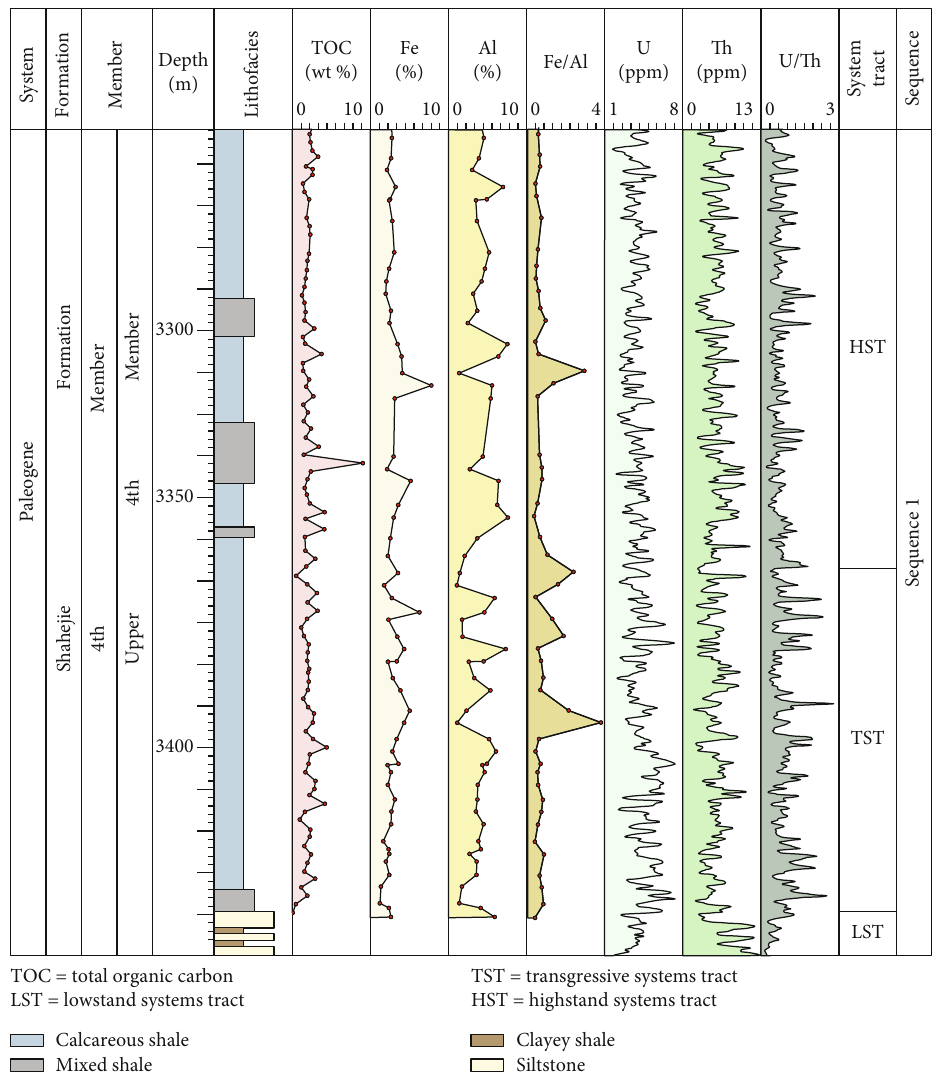
Figure 6: Geochemical parameters and sequence stratigraphy of the Es4u shale in Well A in the Dongying Depression.